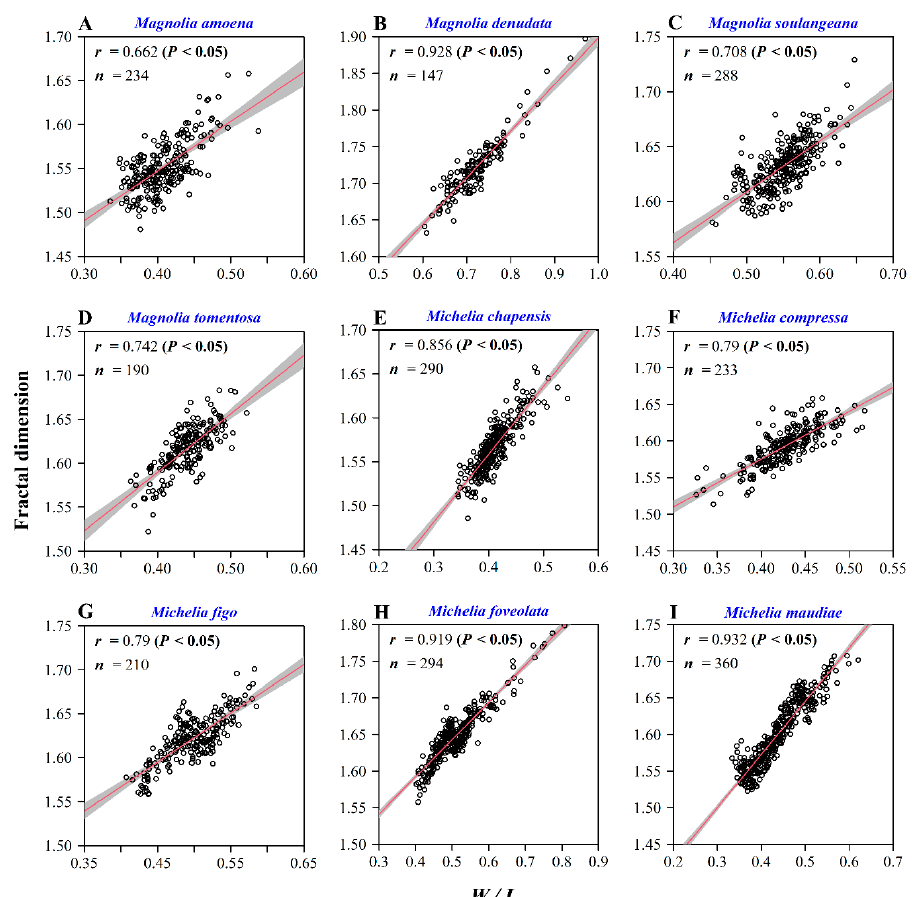
Figure 5. Correlation analysis for the ratio of leaf width to length and the leaf shape fractal dimension. Here, r is the correlation coefficient, and n represents the sample size. Panels ( A − I ) represent different Magnoliaceae species.